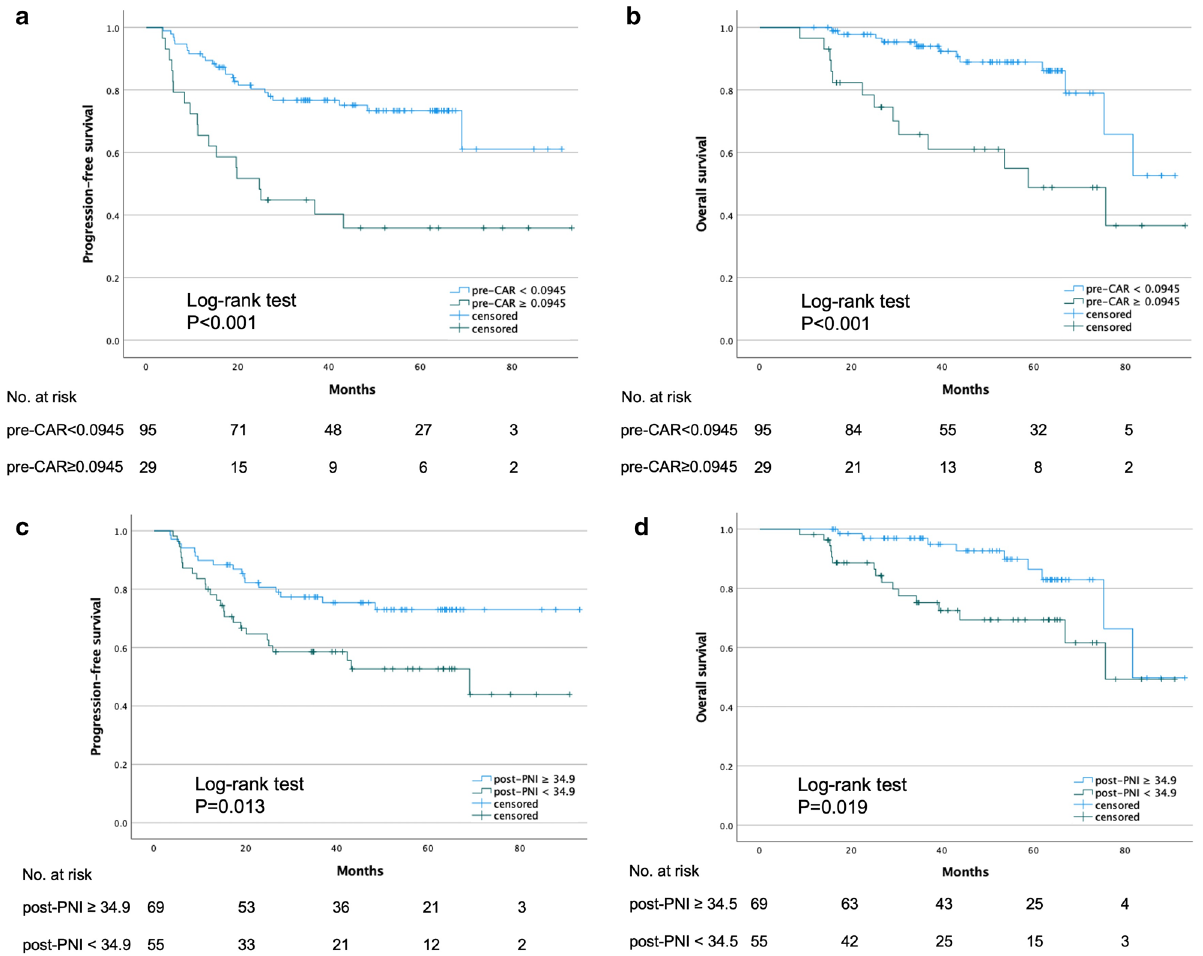
Figure 2. Kaplan–Meier curves for progression-free survival (PFS) and overall survival (OS) according to the pre-CAR ( a , b ) and post-PNI ( c , d